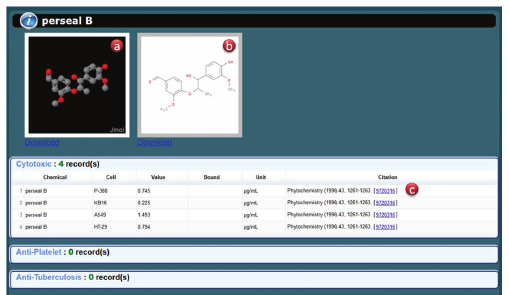
Figure 1: Content of a typical TIPdb entry. (a) 3D structure, (b) 2D structure, and (c) activity data and